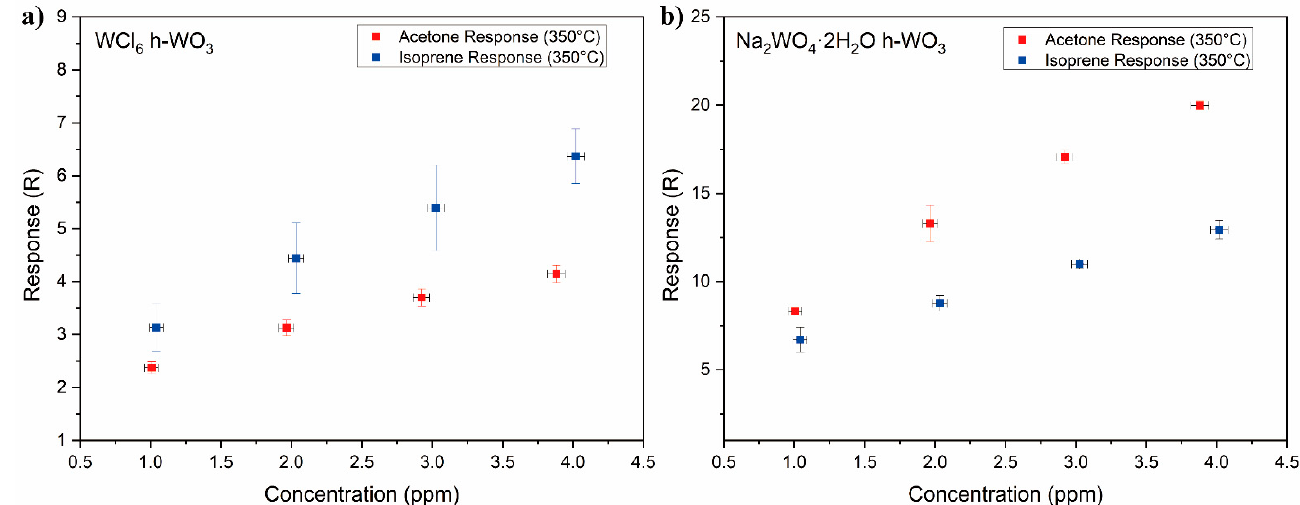
Figure 4. Comparison of the gas sensing response of the WCl 6 h - WO 3 sample ( a ) and the Na 2 WO 4 · 2 H 2 O sample towards acetone and isoprene at 350 °C for 1, 2, 3 and 4 ppm gas concentrations ( b ) along with their standard deviations.